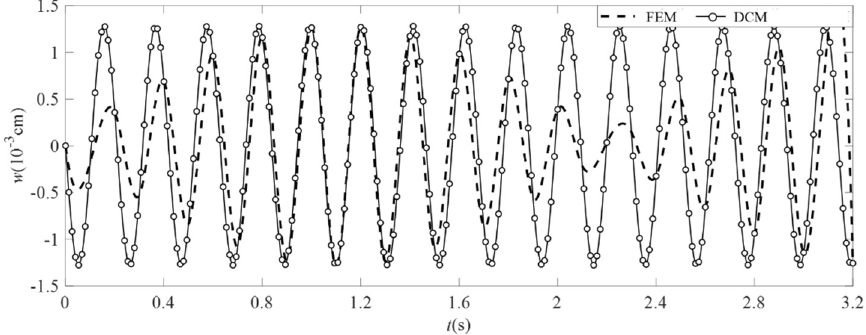
Figure 15. DC solution and finite element solution of time-history displacement of the center point ( T = 3.2 s, FEM ∆ T = 0.1 s). Table 5. Calculating time of FEM and DCM.